Question: Author a descriptive caption for the visualization shown.
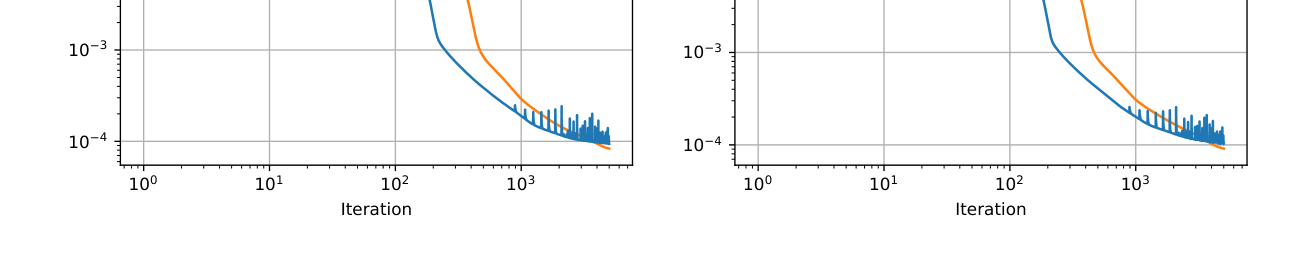
Answer: Experimental performance of the machine learning models. The whitebox model consists of fan-in, reconfigurable, and fan-out sections, each modelled as a real-valued tri-diagonal Hamiltonian in addition to a linear dependence on voltage for the reconfigurable section. (a) Results of training the different models on the experimental dataset. The MSE is plotted versus iteration number (b) The results of evaluating the different models on the testing set.